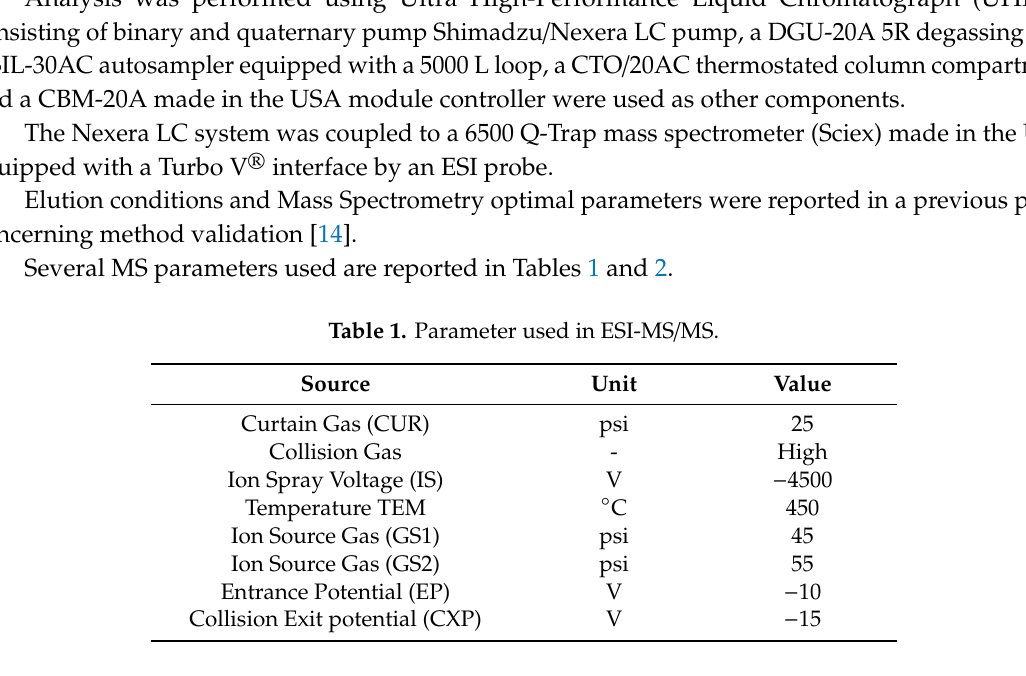
Table 2. m / z, declustering potential and collision energy